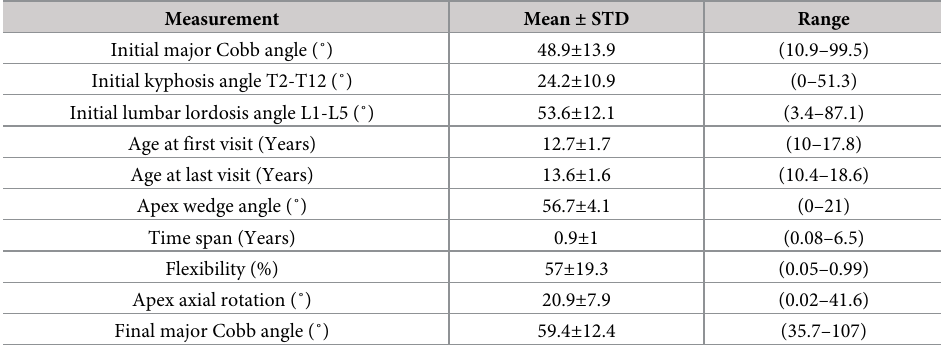
Table 1. Description of continuous features.